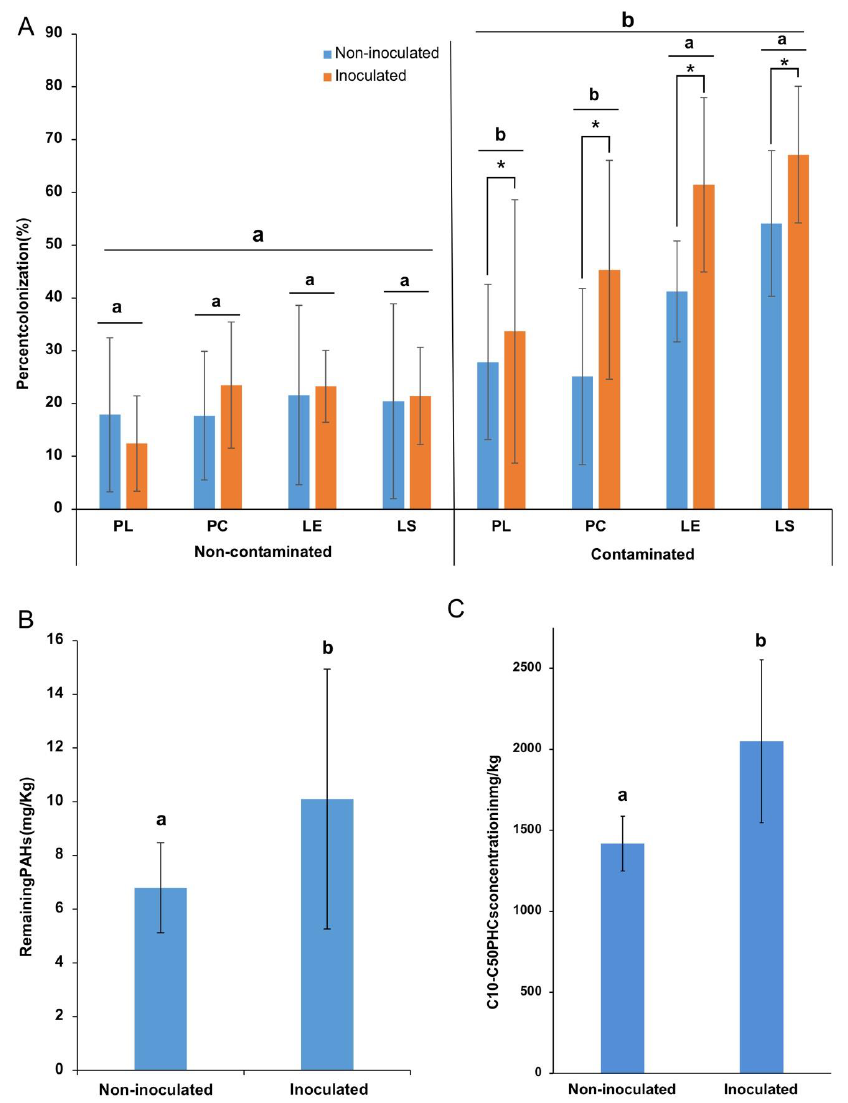
Figure 5. ( A ) Average AMF root colonization percentage for each plant species in both soil contamination levels . PL: Persicaria lapathifolia ; LS: Lythrum salicaria ; LE: Lycopus europaeus ; PC: Panicum capillare . Within each contamination level, plant species not sharing the same letter are significantly different. For each plant species, an asterisk denotes a significant difference between inoculation treatments. ( B ) Average remaining PAHs and ( C ) C10/C50 PHs in the contaminated sediments at harvest. Errors bars are standard deviations.